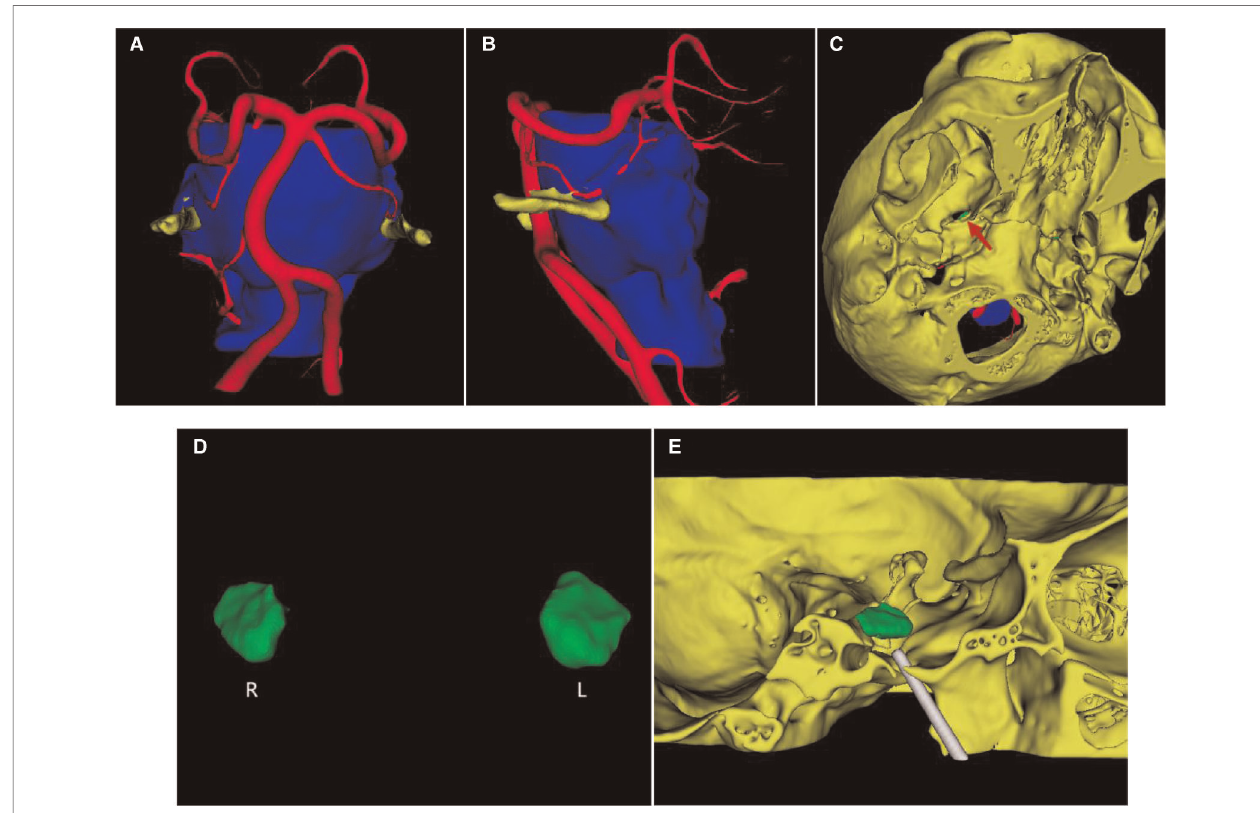
FIGURE 1 | Multimodal image fusion and 3D reconstruction. ( A ) The multimodal image fusion and 3D reconstruction of brain stem, cranial nerves, blood vessels and skull by 3D-Slicer, showing the relationship between the left trigeminal nerve and the left superior cerebellar artery (front view). ( B ) Left view. ( C ) Image made of the FO morphology by 3D reconstruction of the skull (view below). ( D ) The bilateral Meckel cavities. ( E ) Simulation of FO